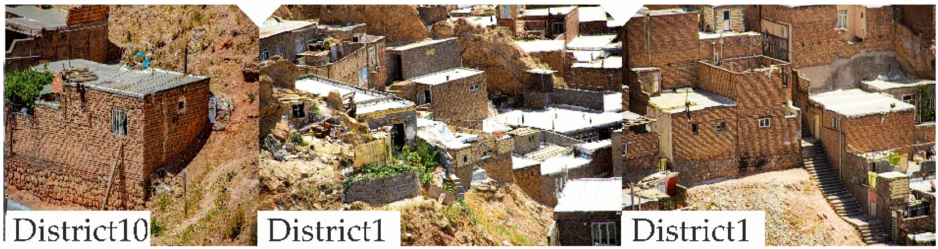
Figure 14. All interior and exterior walls are made of cement